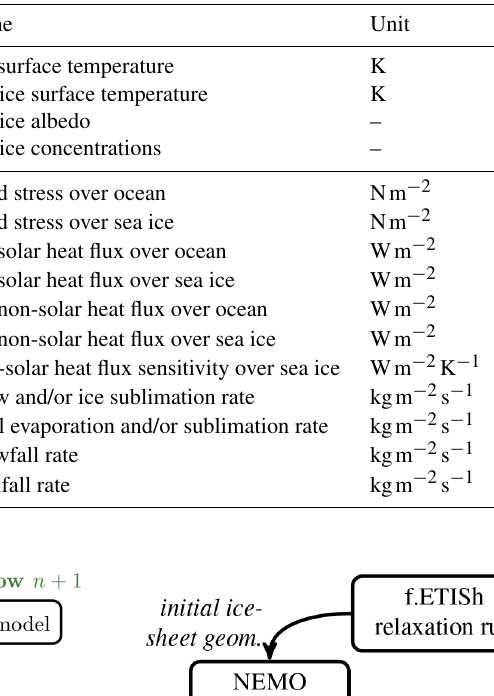
Table 2. NEMO–COSMO list of exchanged variables.